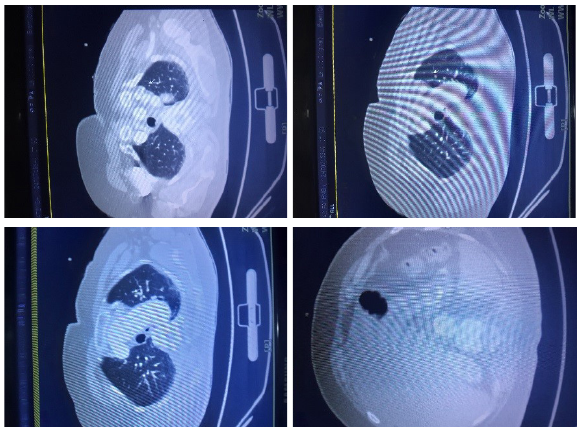
Figure 1. Aortic